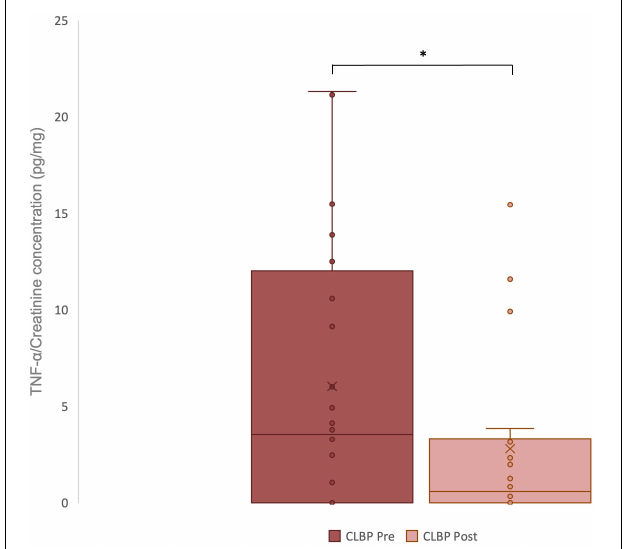
FIGURE 2 | Urinary TNF- α levels in chronic low back pain (CLBP) patients, pre- and post-treatment. For each sample, the urinary concentrations of TNF- α (pg/ml) and creatinine (mg/dl) were assessed. The ratio of urinary TNF- α to urinary creatinine in pg/mg was calculated to correct changes in urine volume. The middle line represents the median and the x represents the mean. The upper and the lower lines of the box represent the first and third quartile respectively and the whiskers include all individual data points within 1.5 times the interquartile range. ∗ p < 0,05.